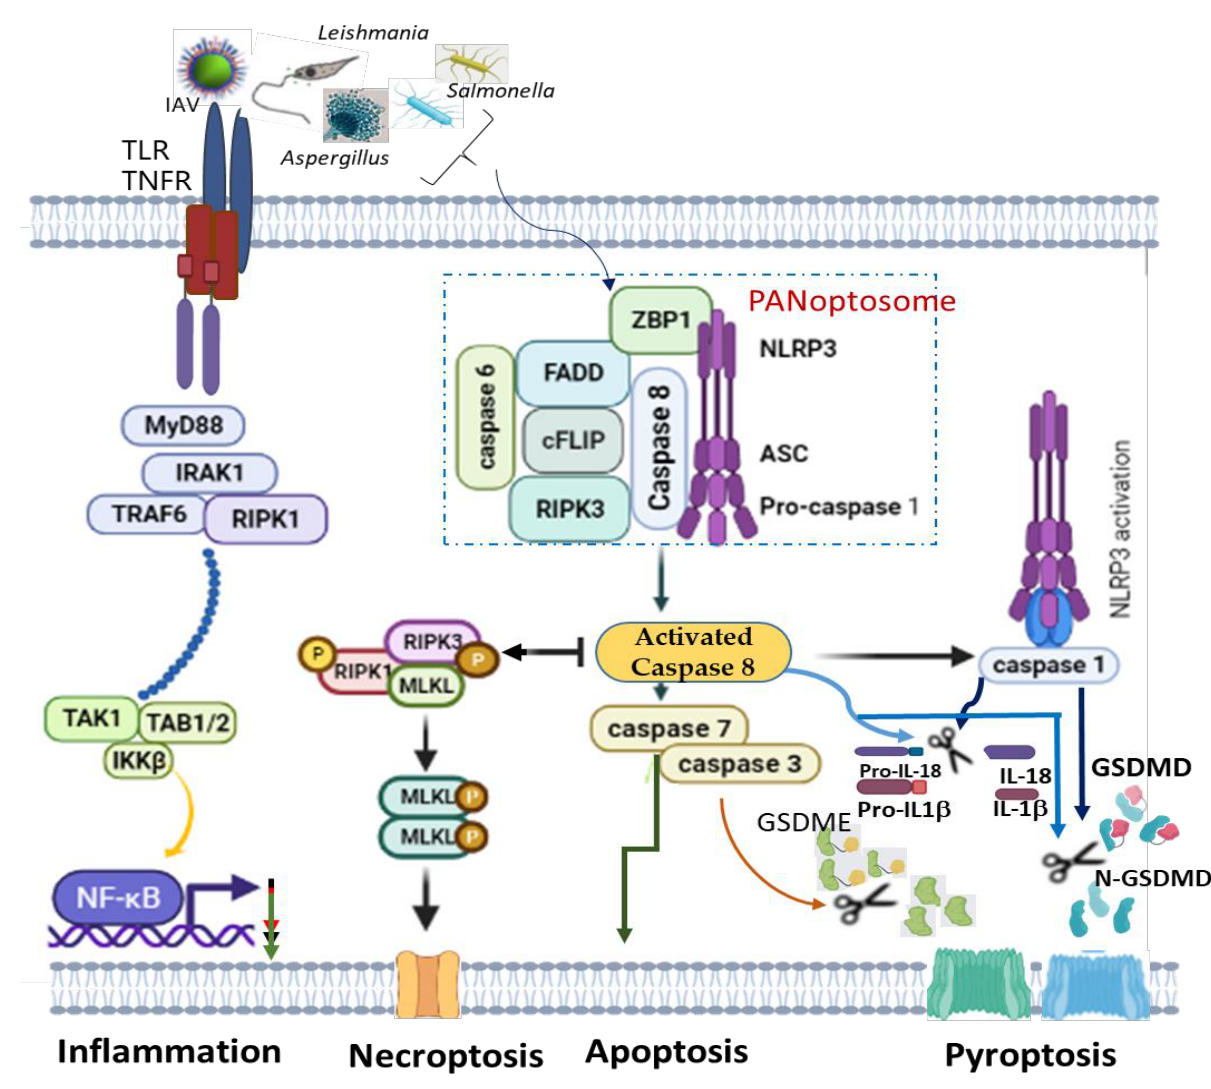
Figure 1. NLRP3 is an essential component of PANoptosome, and activation of a complex of ZBP1-FADD-RIPK3-caspase 8 drives PANoptosis inflammatory cell death. Activated caspase 8 simultaneously induces apoptosis via downstream activation of caspase 3/7 and directly promotes the assemblage of NLRP3 inflammasome activation complex to initiate pyroptosis via the cleavage of pro-IL1 β , pro-IL18 and GSDMD. The reduced activity of the activated caspase 8 drives phosphorylation of MLKL for the induction of necroptosis, while pathogen surface recognition through TLR and TNFR leads to the nuclear binding of NF- κ B for inflammation and PANoptosome-independent necroptosis. NLRP3, Nucleotide- binding oligomerization domain; GSDMD, Gasdermin D; GSDME, Gasdermin E; ZBP1, Z-DNA-binding protein 1; RIPK, Receptor-interacting serine/threonine kinase; MLKL, mixed lineage kinase domain-like pseudokinase; FADD, fas-associated death domain; MyD88, myeloid differentiation primary response 88; NF- κ B, nuclear factor kappa light chain enhancer of activated B cells; IRAK, interleukin receptor-associated kinase; TAK1, transforming growth factor b-activated kinase 1; TRAF, TNF receptor-associated factor; cFLIP, Cellular caspase-8 (FLICE)-like inhibitory